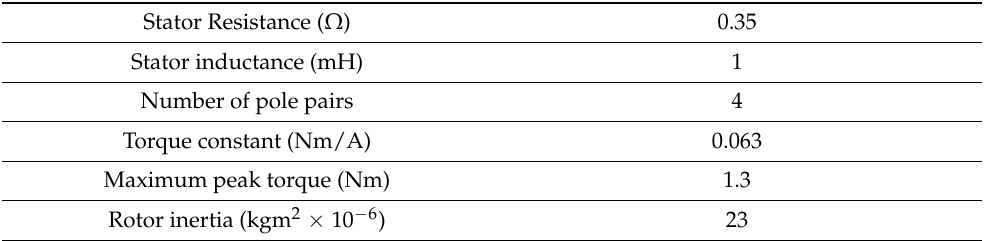
Table 4. Parameters of a Trinamic BLDC motor.